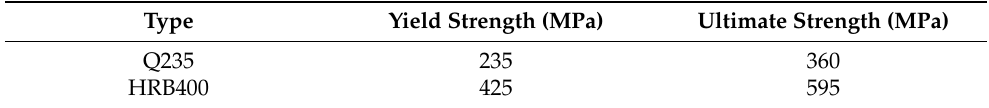
Figure 4. Tensile stress – strain relationships: ( a ) tensile stress – strain relationship of UHPC; ( b ) tensile stress – strain relationship of RC.